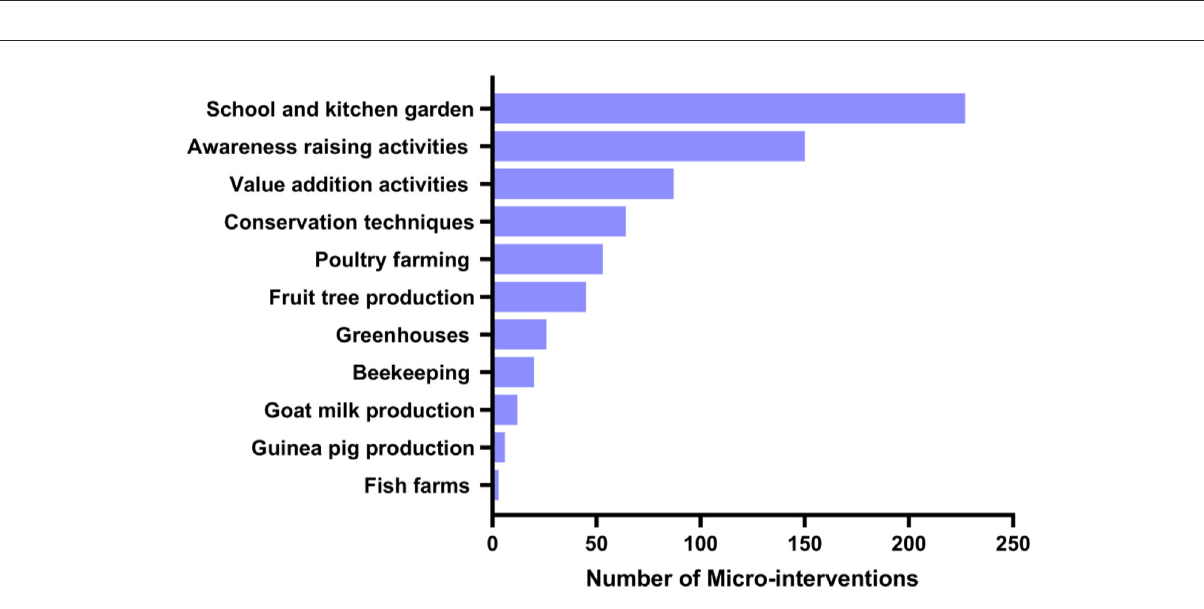
food produced in the ten food groups of the MDD-W